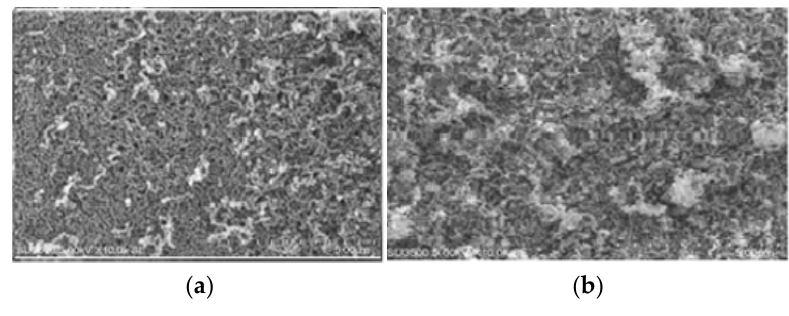
Figure 4. Surface morphology of MIP ( a ) and NIP ( b ).